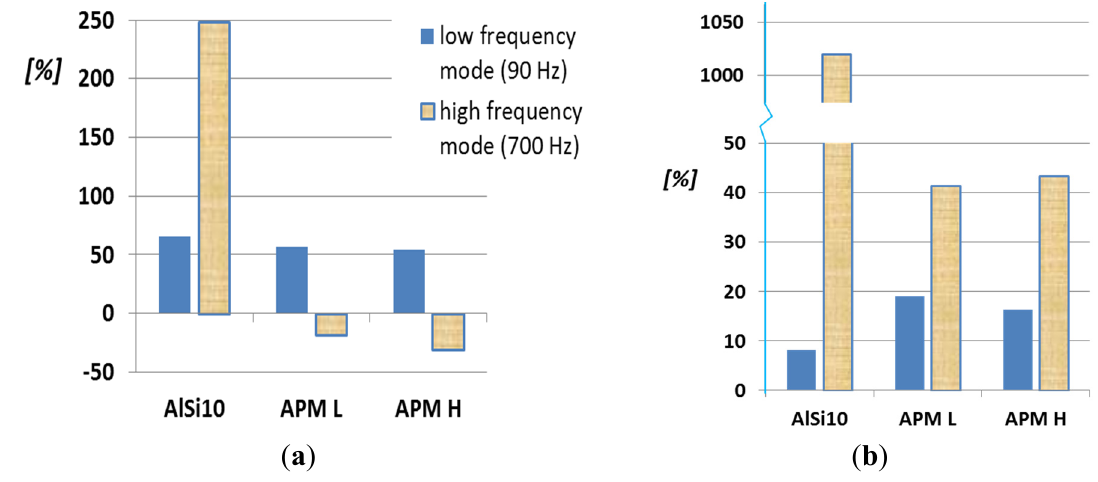
Figure 5. ( a ) Percentage variation of damping ratio DR of filled structures, with respect of empty tube [6]; ( b ) Percentage variation of DR of foam-filled structures after 10,000 bending cycles, with respect to hollow